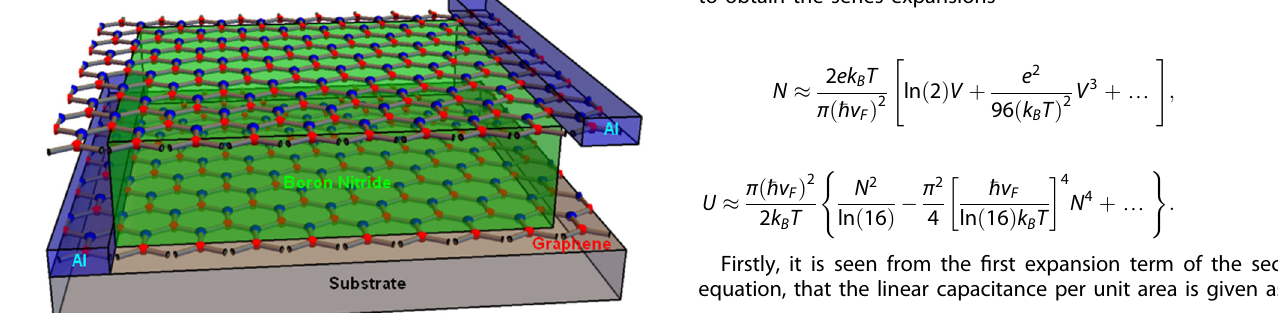
This is to be compared with the geometrical capacitance C G . The permittivity of BN is ε = 4.0 ε 0 (ref. 24). Hence taking the dielectric thickness to be t = 7 nm, being suf fi cient to stop tunneling current, gives a geometric capacitance value of C G = 5.06 fF μ m − 2 . At the typical temperature of 1 K , we have C 0 = 0.0536 fF μ m − 2 , which is much smaller than the geometric capacitance by two orders of magnitude. Hence, our initial assertion to ignore the effect of the geometric capacitance at low temperatures and zero bias is satis fi ed to a high accuracy. This situation is illustrated in Fig. 2. In general, a dielectric thickness of no less than 2 nm should be suf fi cient to completely disallow tunneling. It could be made thick as long as C Q dominates by an order of magnitude, yielding the available range of dielectric thickness as 3 nm < t < 70 nm. Since, the monolayer BN is around only 2.489 Å in thickness, 24 t is suf fi ciently high to warrant an expitaxial growth. Structures of comparable type are being